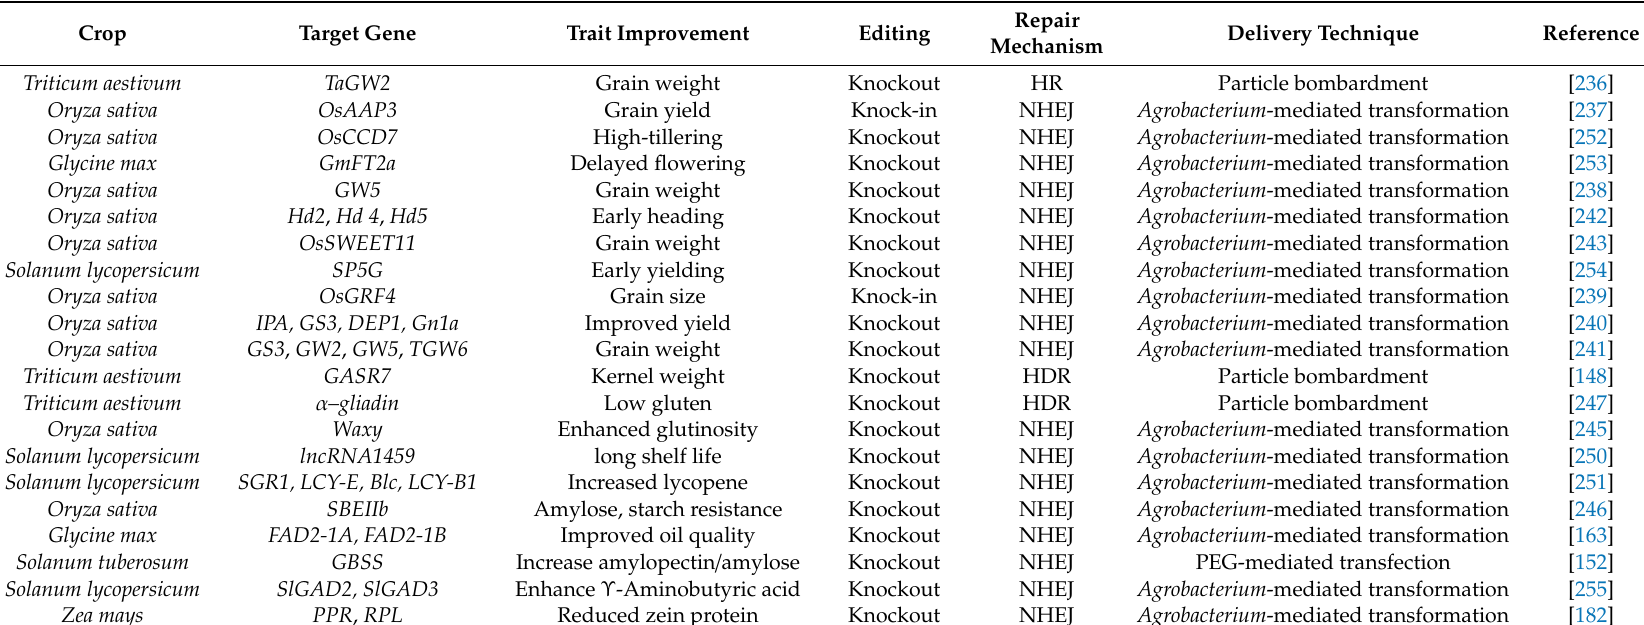
Table 5. Summary of CRISPR / Cas9 applications in major crops for yield and quality